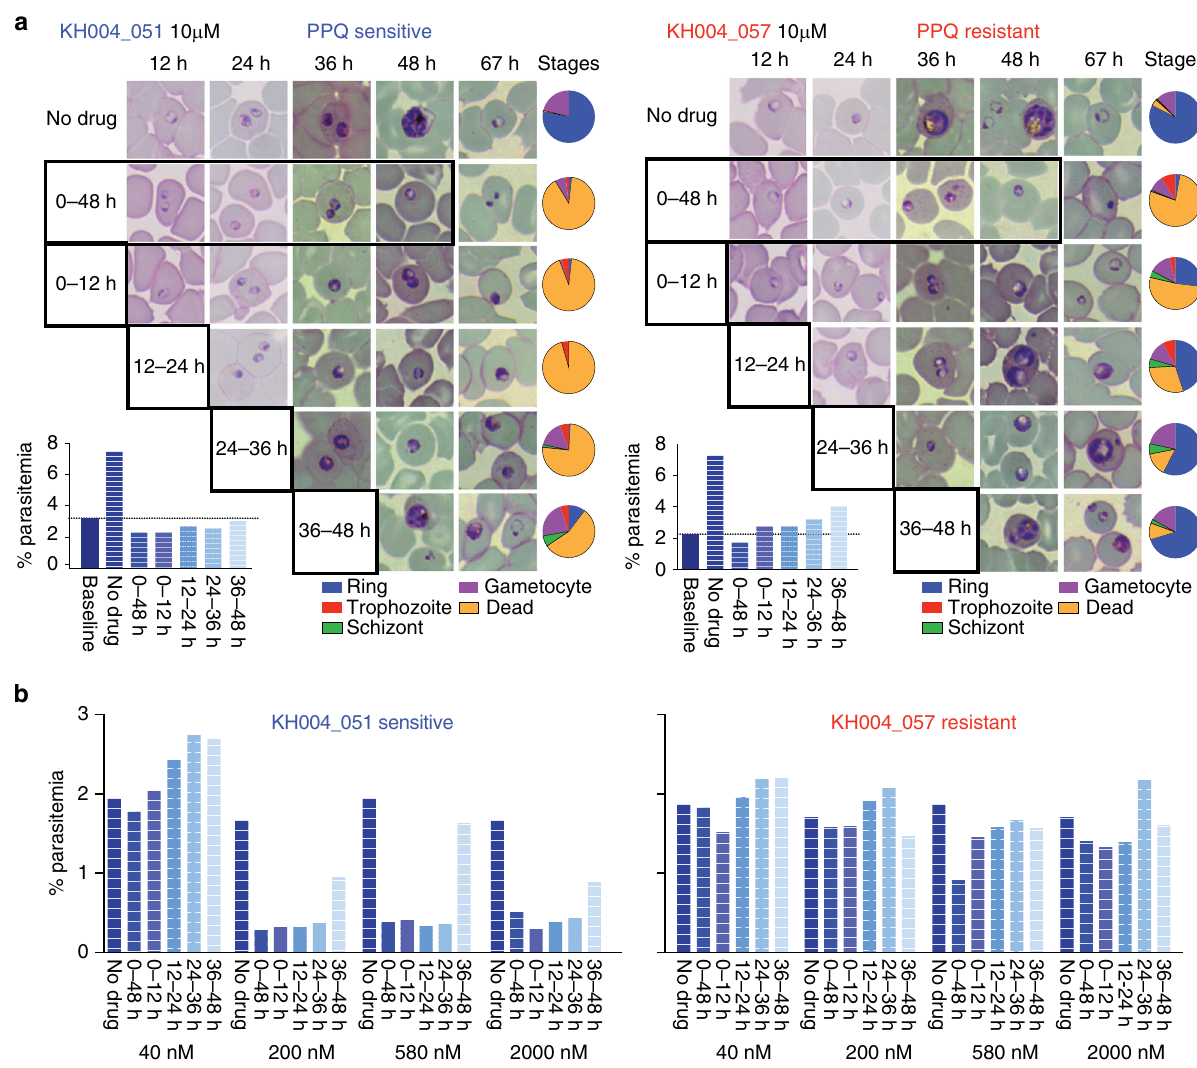
Fig. 5 Late-stage parasites are less susceptible to PPQ and resistant parasites can tolerate high PPQ doses for 12 h. PPQS (KH004_051, blue) and PPQR (KH004_057, red) were synchronized and exposed to PPQ for 12 h, and their ability to survive to the next life cycle was visualized by microscopy a to determine both stage and parasitemia b . Representative images a and parasite stage distribution (blue = ring, red = trophozoite, green = schizont, purple = gametocyte, and yellow = dead) were calculated and represented by pie charts. Parasitemias resulting from these PPQ exposures were analyzed by FACS 72 h after exposure b . Under high drug concentrations (10 µ M, a ), there is evidence that the PPQR parasite (KH004_057, red) can tolerate 12 h of PPQ exposure up to 2000 nM. Conversely, the PPQS parasite (KH004_051, blue) does not survive at PPQ concentrations of ≥ 200 nM, except a few parasites that survive in the later (36 – 48 h) time of exposure, where there was evidence of some parasite